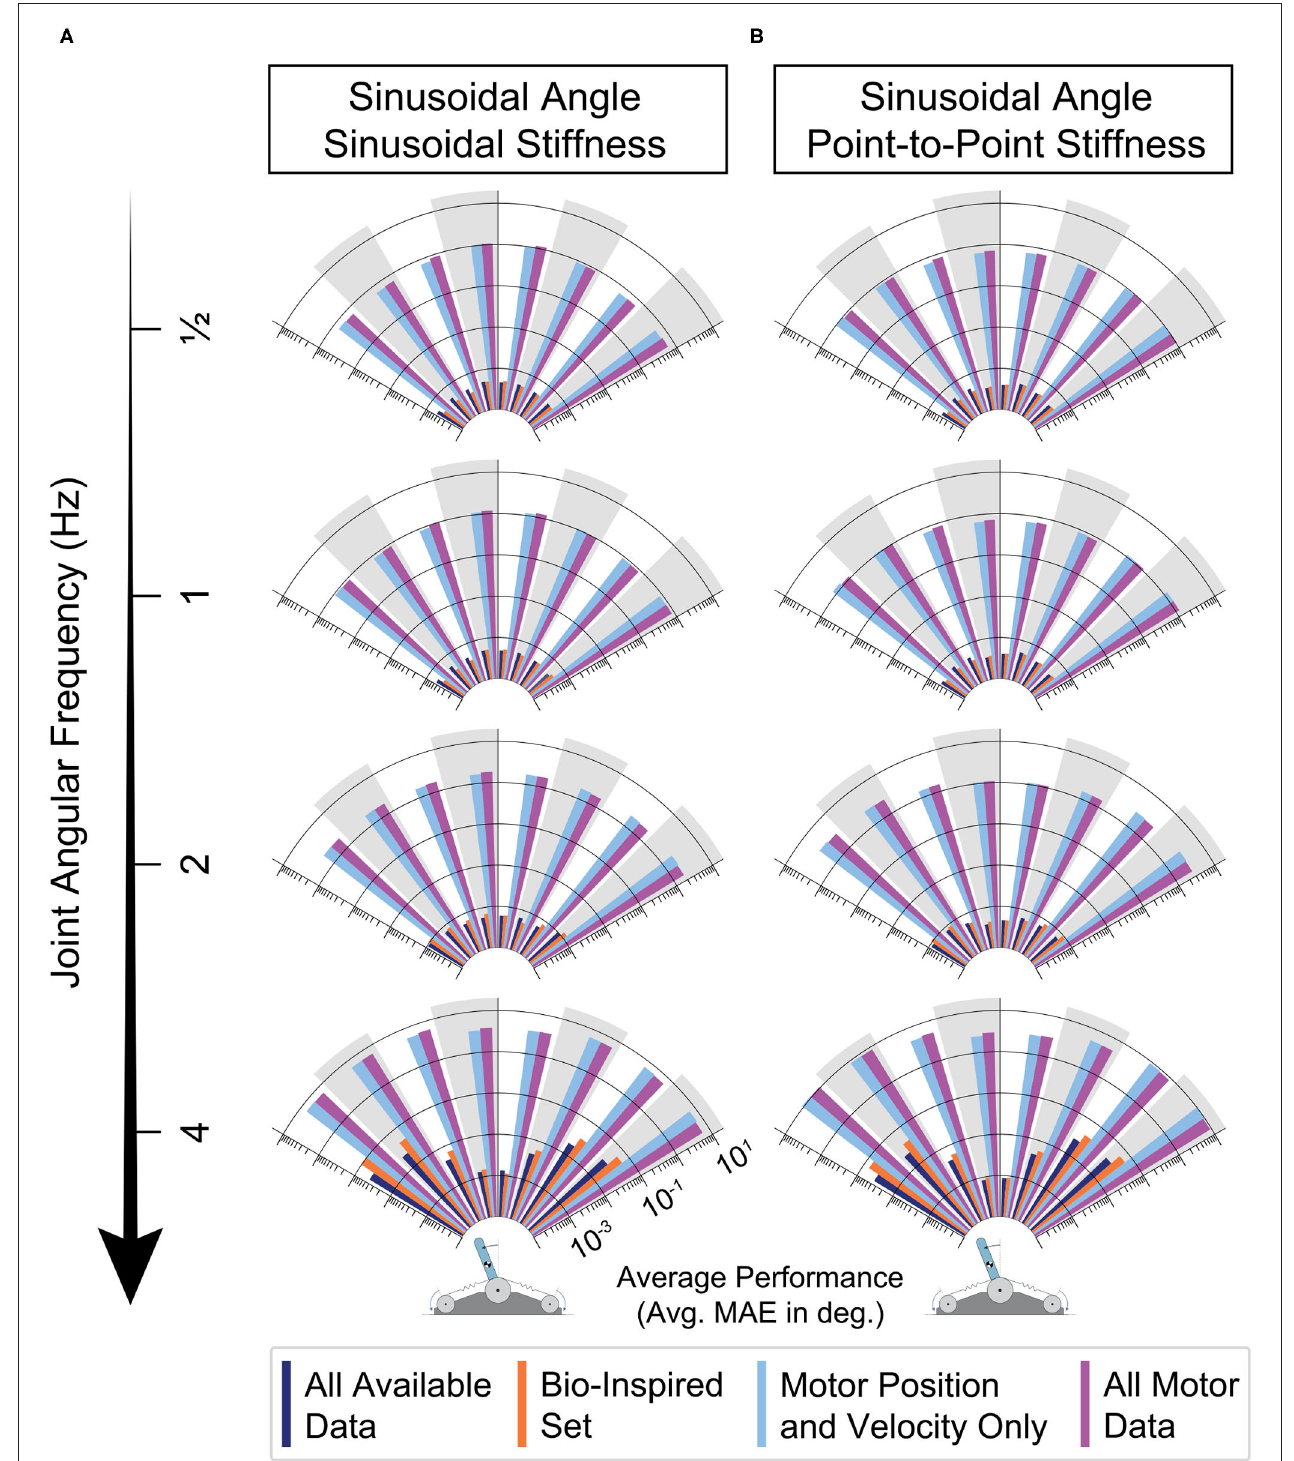
FIGURE 12 | Radial bar plot of the average performance (MAE) of each sensory set across the joint angle space as the joint angular frequency is increased and the joint stiffness was either varied (A) sinusoidally (twice the frequency) or (B) as a point-to-point task. For either task, ANNs trained with tendon tension ( dark blue & orange ) generalized better to higher frequency movements, only worsening slightly when the movements becomes fastest. For these two sets, when movements were the fastest, the largest errors occurred at the boundaries of the sinusoidal movement ( à la speed-accuracy trade offs).